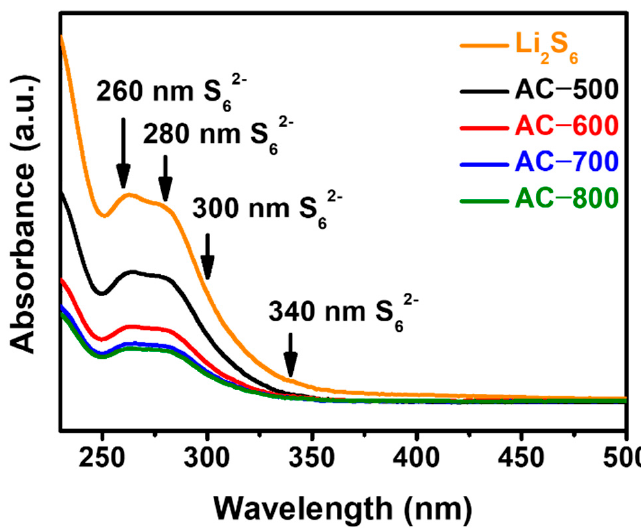
Figure 6. UV-vis absorbance spectra of the AC samples as the functional separators.